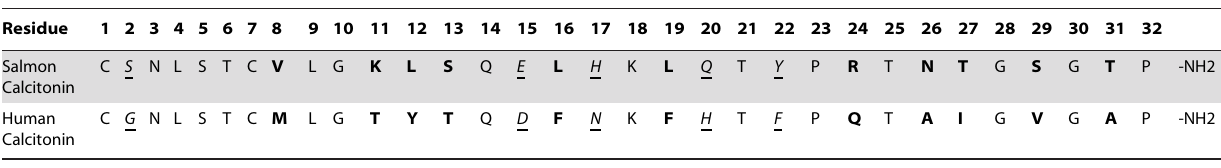
Table 1. Amino acid sequence comparison of salmon and human calcitonin.